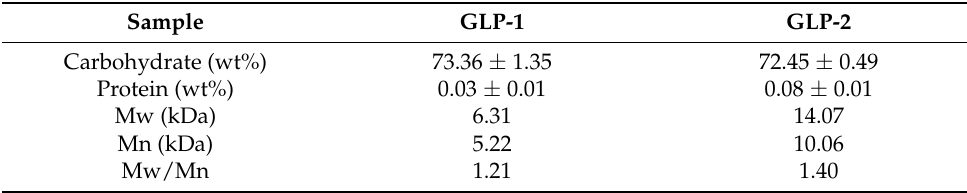
Figure 1. Stepwise elution profiles of CGLP-1 ( A ) and CGLP-2 ( B ) on DEAE-Sepharose fast-flow column. Elution profiles of the 0.1 M NaCl fraction obtained from CGLP-1 ( C ) and CGLP-2 ( D ) on Sephacryl S-300 HR column. HPGPC graphs of GLP-1 ( E ) and GLP-2 ( F ). Table 1. Chemical compositions and molecular weights of GLP-1 and